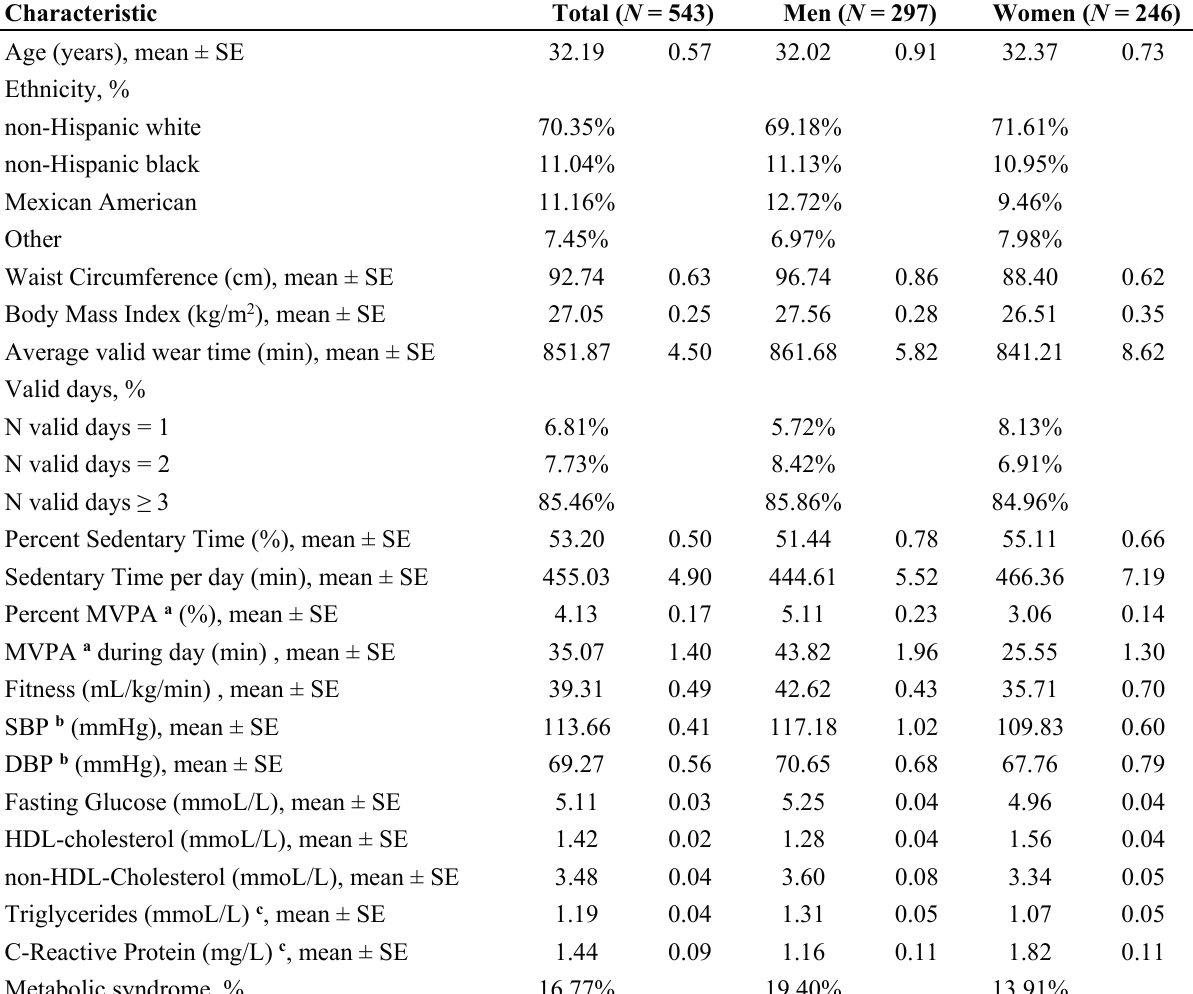
Table 1. Participant demographics, accelerometry measures, fitness and cardio-metabolic